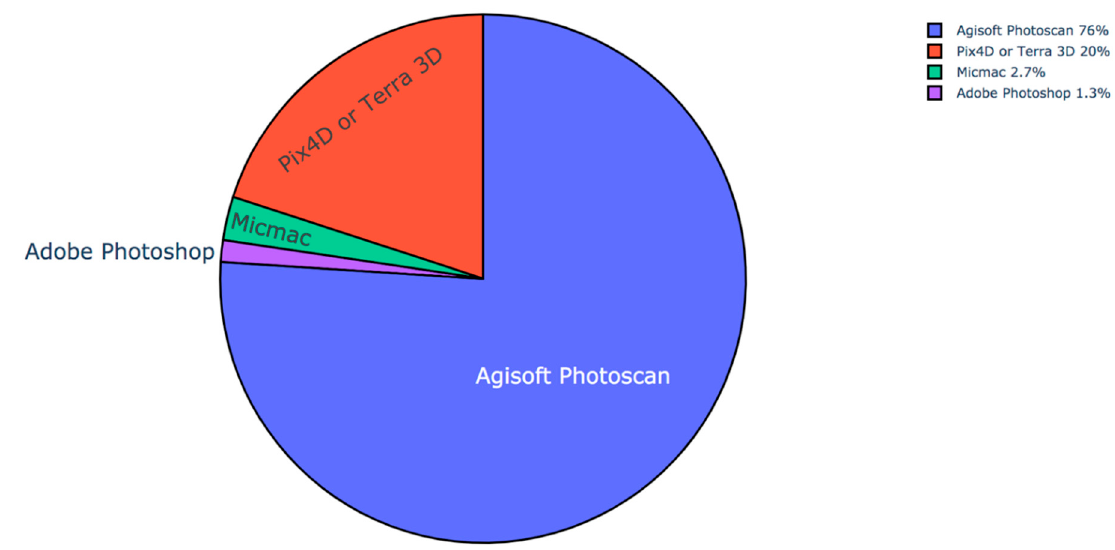
Figure 6. The orthomosaic software used by the studies. Percentages indicate the frequency of use surveyed from the studies.